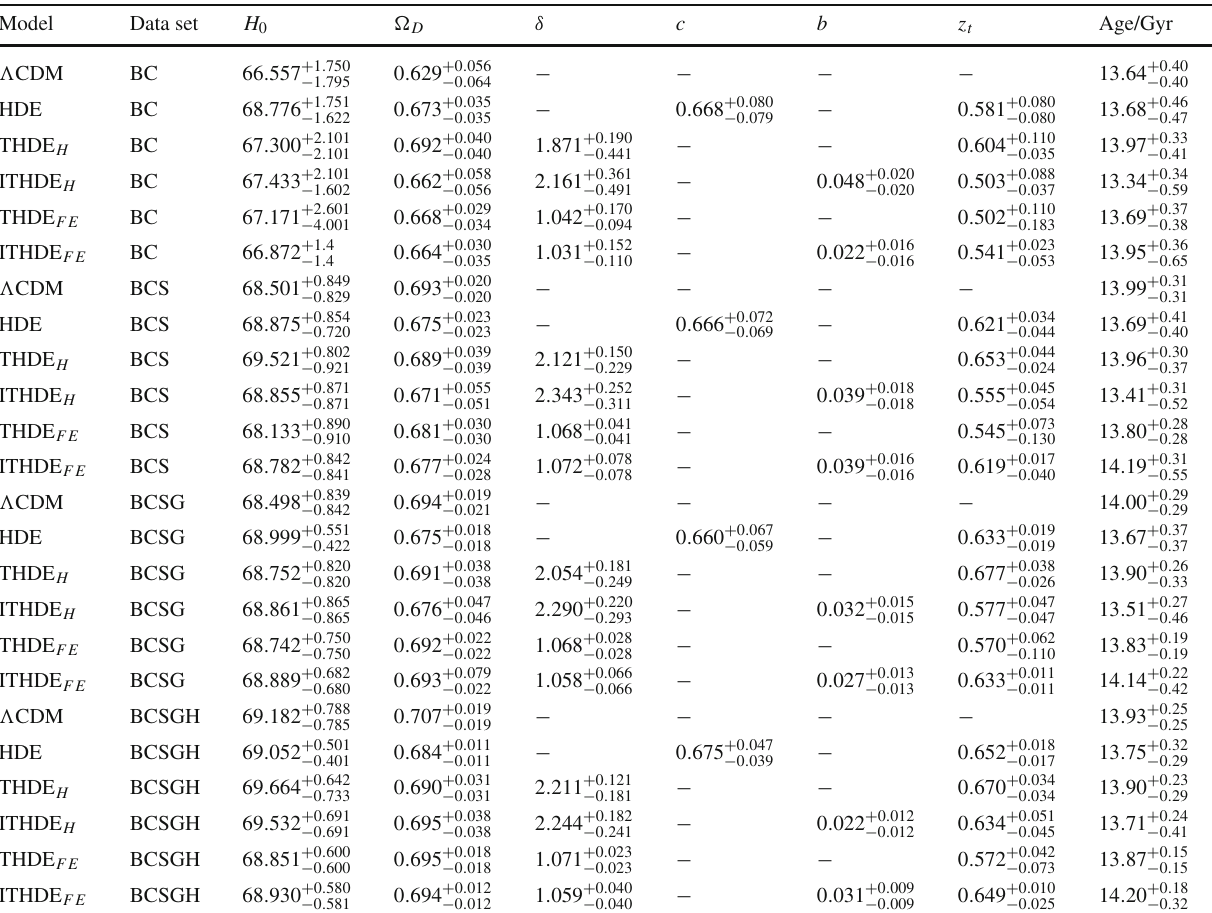
the local Hubble constant H 0 (H) and Gamma-Ray burst (G) have been used. The H and FE index stand for the Hubble horizon and the future event horizon